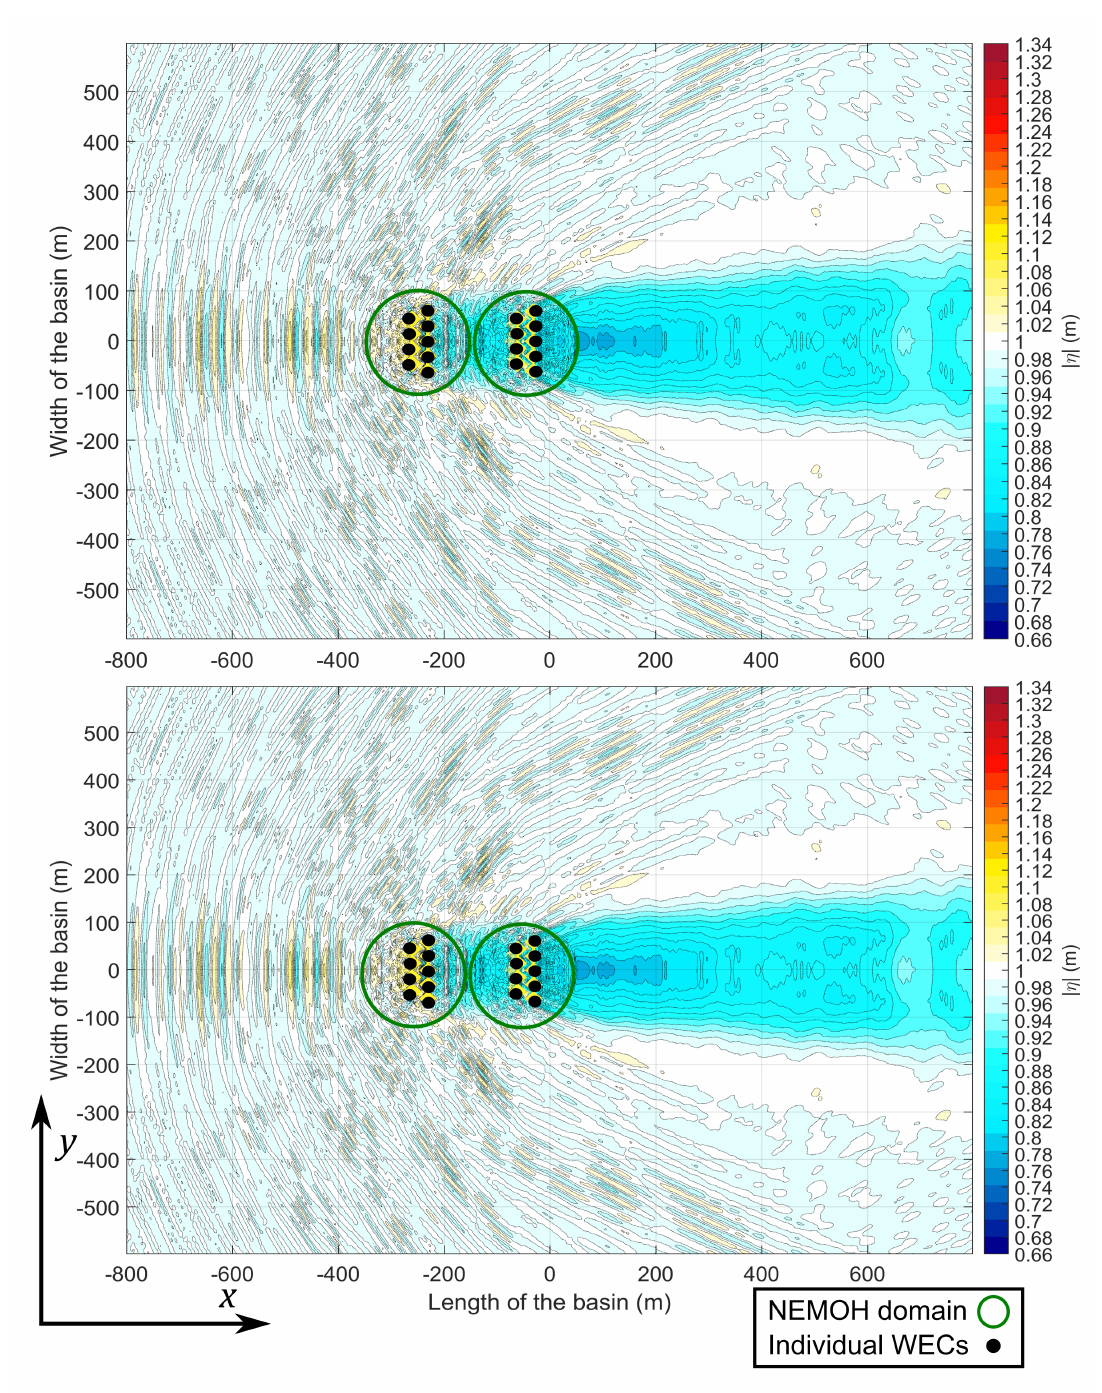
Figure 9. Total wave field around two WEC arrays, I (left) and II (right), of nine heaving buoys for Pierson–Moskowitz irregular waves of H m 0 = 2 m, T p = 6 s (top row) and T p = 8 s (bottom row). Interarray separation distance D 1 = 200 m or 2 r c . Wave incidence angle β = 0 ◦